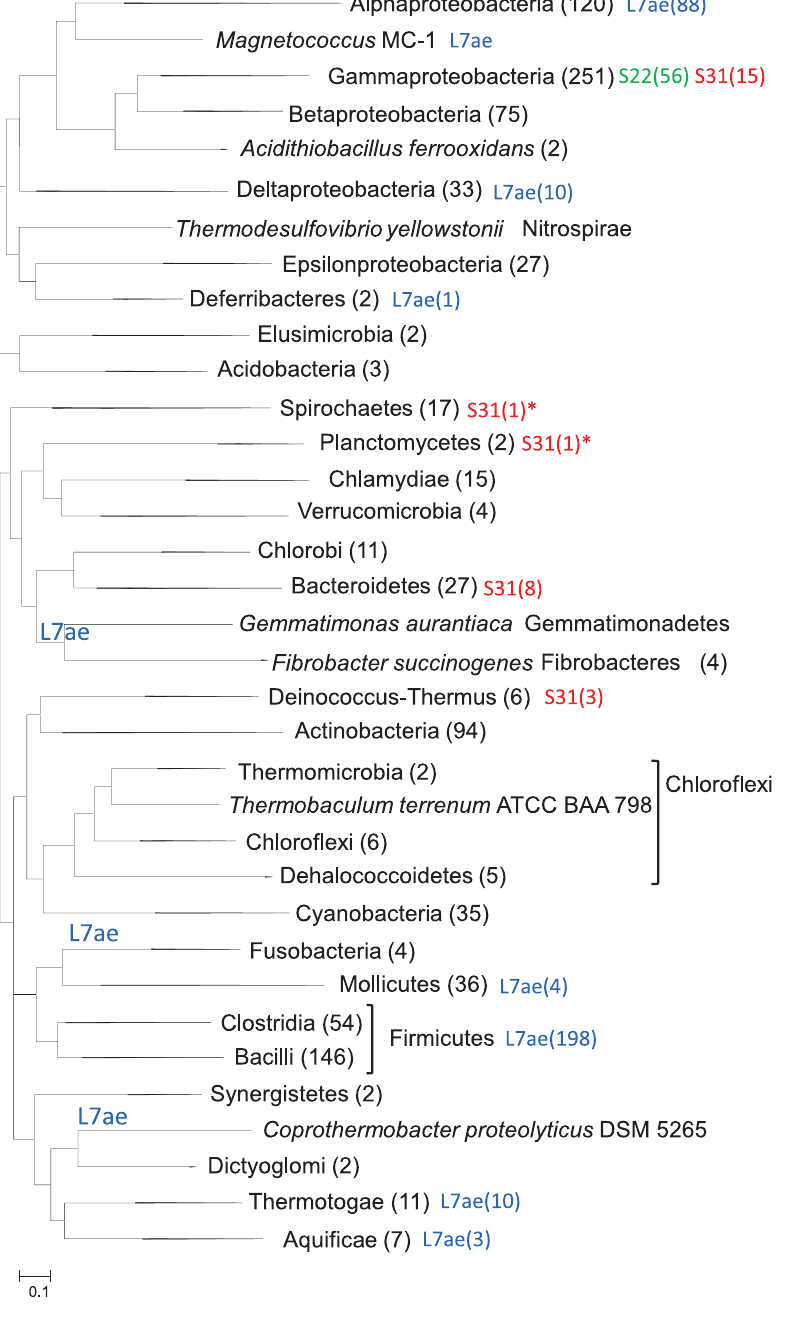
Figure 4. Phyletic distribution of non-ubiquitous bacterial r-proteins that according to the parsimony reconstruction do not appear to be ancestral. Numbers in parentheses following taxonomic group names represent number of species in that group. Numbers in parentheses following r-protein names represent number of species on that branch that have this r-protein. L7ae on branch means all genomes of this branch included in the dataset have this r-protein. Asterisks point on two phyla where S31 protein has been found in genomes that were not included in the dataset.